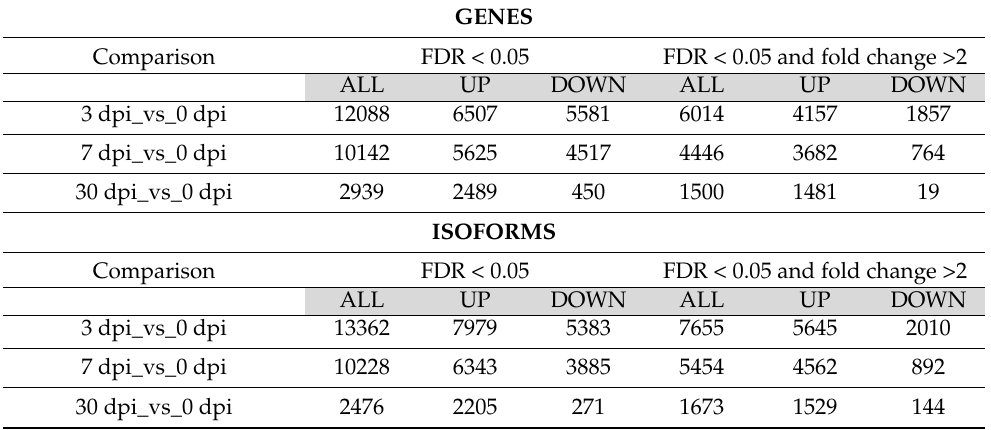
Table 1. Total number of genes and isoforms with significant differential expression. Three experi- mental conditions (3 dpi, 7 dpi and 30 dpi) are specified in comparison to control (0 dpi). FDR cut off <0.05. dpi = days post